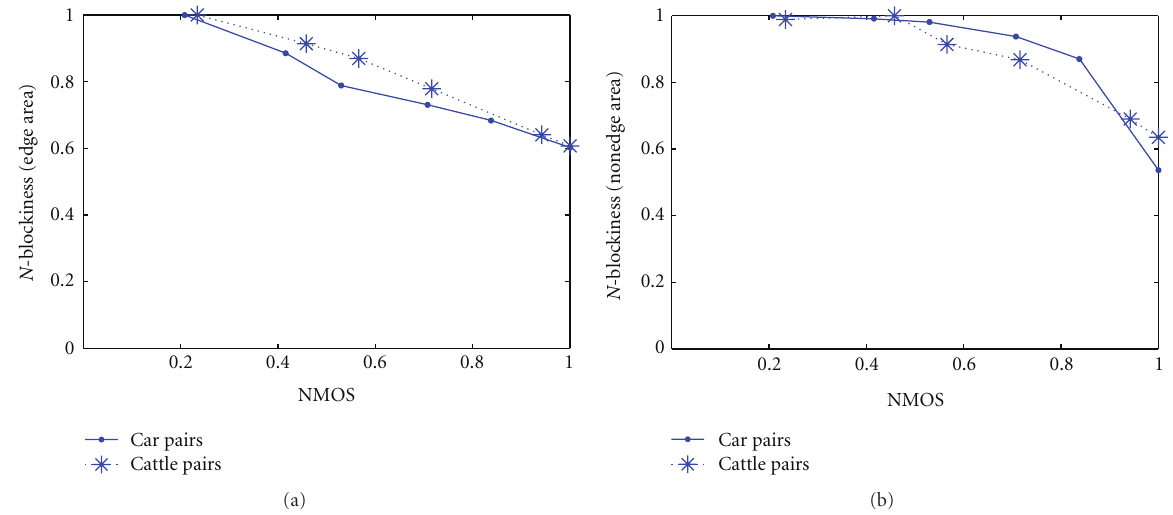
Figure 5: Normalized MOS versus blockiness for edge and nonedge areas of di ff erent Car and Cattle image pairs. (a) NMOS versus N - blockiness (edge areas, B e ), (b) NMOS versus N -blockiness (nonedge areas, B n